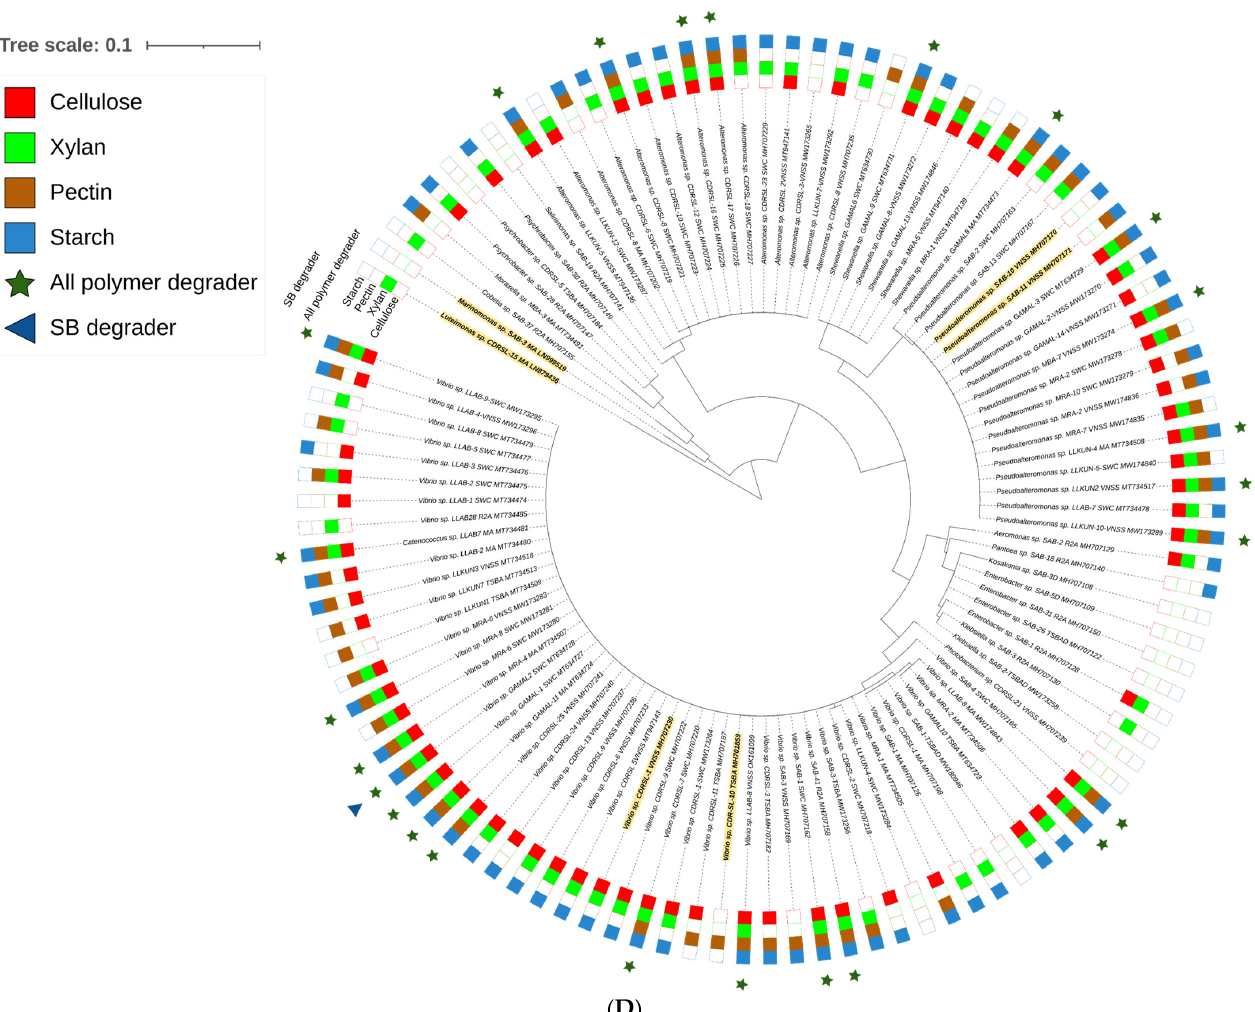
Figure 2. Maximum likelihood method based phylogenetic sub tree of cultured strains (n = 238) belonging to ( A ) Alpha-proteobacteria ( B ) Actinobacteria , ( C ) Bacilli group and ( D ) Gamma-proteobacteria were inferred using Mega 7 software [39] considering a total of 1514 positions in final datasets with general time reversal (GTR+G+I) method. Branch length is observed as 1.81442122 and analysis involved 239 nucleotide sequences. The tree contains datasets with polymer degrading potentials represented outside taxon name in coloured blocks. Filled and blank blocks represent positive and negative activity respectively against tested substrates by the respective taxa. Strains degrading all polymers ( ) and raw sugarcane bagasse ( ) are appropriately highlighted. Novel strains at genus and species level (published and putative) are highlighted with bold and yellow background. Gaps and ambiguous bases were removed from the final data sets. The final tree was visualized and edited in iTOL server.